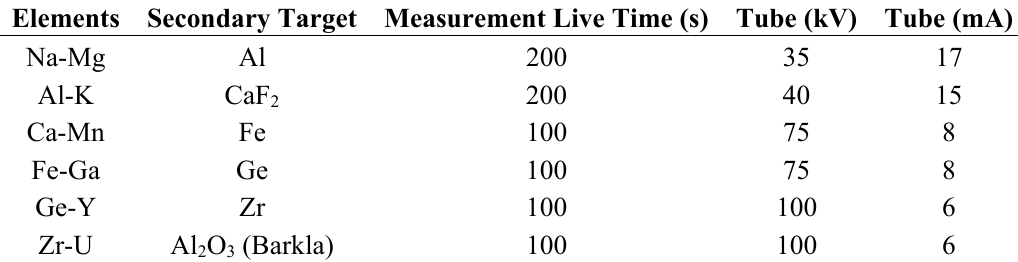
Table 1. Epsilon 5 XRF measurement